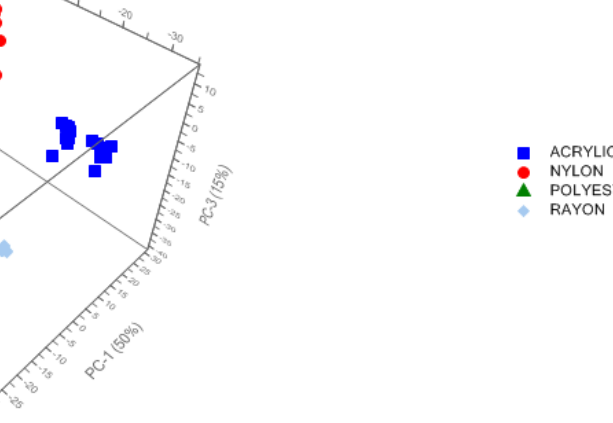
Figure 5. PCA model scores plot in 3D.